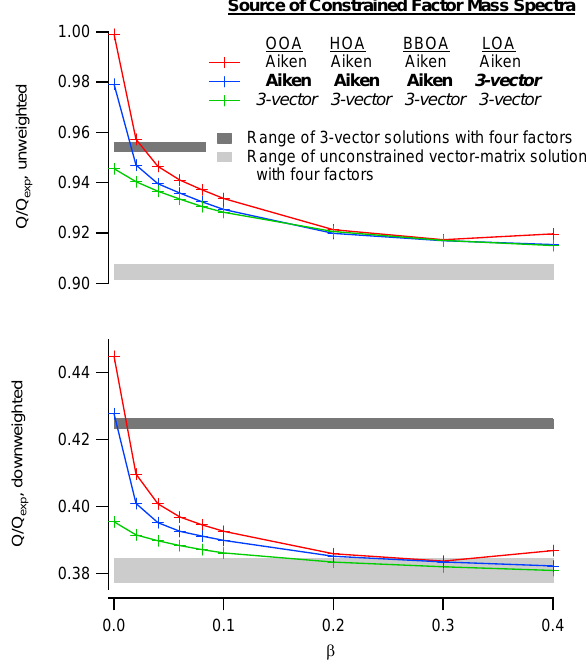
Fig. 5. Values of Q/Q exp for four-factor solutions of the vector- matrix model in which the factor mass spectra have been con- strained to a priori spectra vs. β . The β parameter can fully con- strain the a priori spectra ( β =0) or allow them to relax, as described by Eq. (6). The downweighted Q/Q exp values for solutions with β ≥ 0.3 fall within the range of the unconstrained solutions (i.e., solved without a priori information about factor mass spectra) of the same model (lighter grey region). The solutions in which the constrained OOA, HOA, and BBOA spectra come from the high- resolution MS (HR-MS) solution and the LOA spectrum comes from the four-factor solution of the 3-vector model (blue curve) is used for further